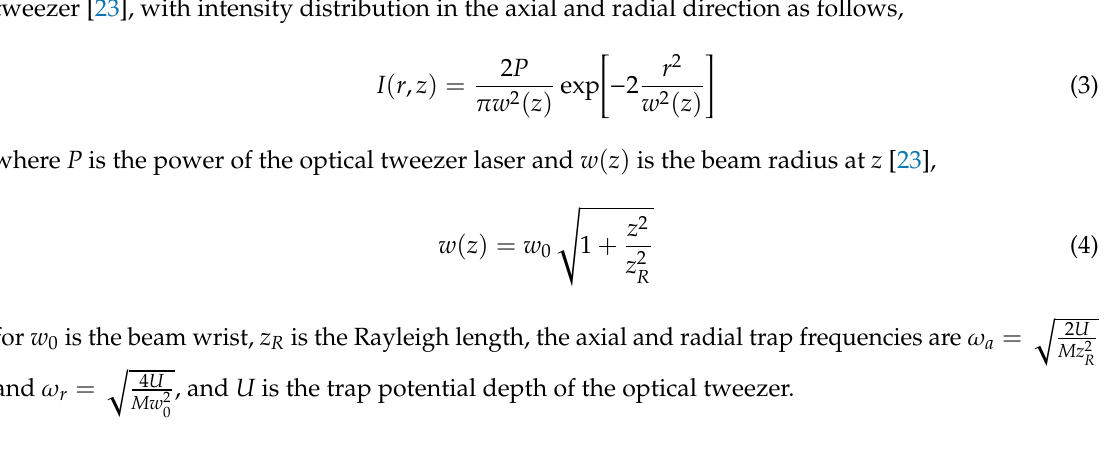
Figure 5. Experimental setup. Polarization-maintaining (PM) fiber; Multi-mode (MM) fiber; magneto- optical trap (MOT); optical-dipole trap (ODT), otherwise the optical tweezer; optical isolator (OI); acousto-optical modulator (AOM); polarization beam splitter (PBS); single-photon counting module (SPCM); ultra-high vacuum (UHV). The red dash box shows the laser intensity fluctuation feedback loop by controlling the diffraction efficiency of AOM 1 to stabilize the intensity fluctuation of the 1064-nm laser. The blue dash box shows the measurement setup of the trap frequency of optical tweezer. The green dash box shows the single-atom cooling and trapping system, the anti-Helmholtz coils, but the cooling and repumping laser beams of the MOT are not shown here. Then, by measuring the transfer efficiency of single-atom between the MOT and the optical tweezer to observe how the intensity fluctuation of different frequency acts on single-atom trapping lifetime and Figure 6 shows a typical atomic transfer signal between the MOT and the optical tweezer. As shown in Figure 6, the transfer efficiency gets extremely low when the modulation frequency is resonant with the trap frequency and its double frequency of the optical tweezer.